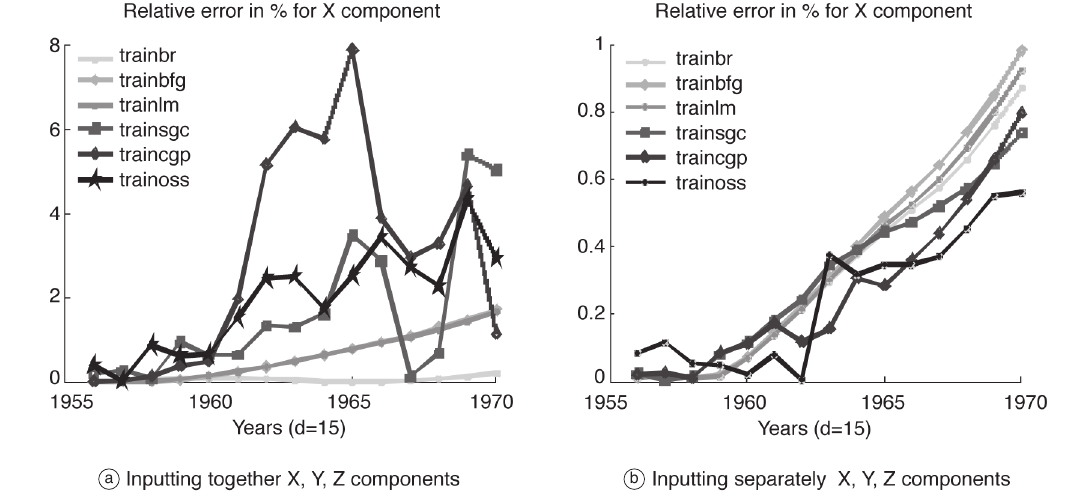
a Fig. 3a,b. Variation of X-component prediction error by the year of prediction, for different training functions.